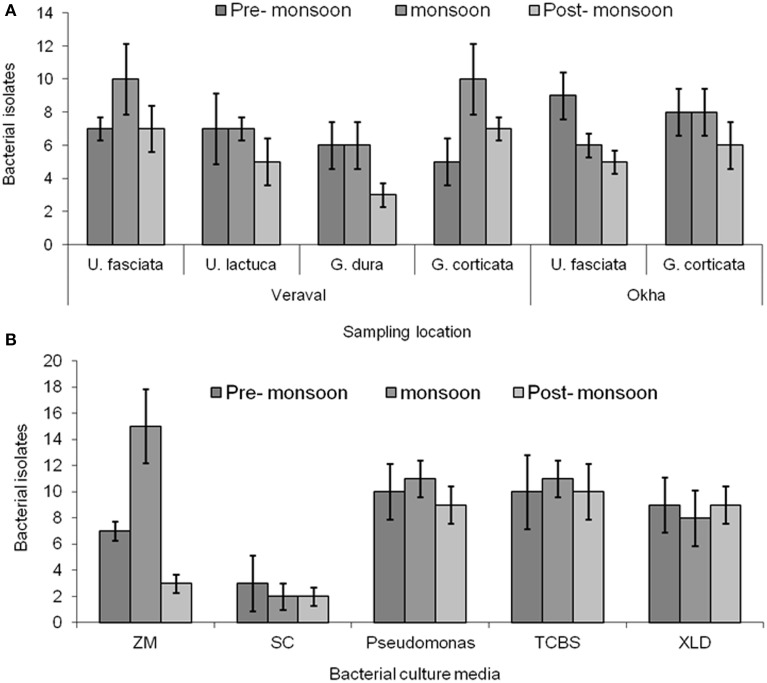
Bacterial isolation. (A) Enumeration of bacteria from different macroalgal samples such as Ulva fasciata, U. lactuca, Gracilaria dura and G. corticata. (B) Small plantlets of macroalgae were placed on the different culture media for isolating bacteria from them. Bars indicate, deviation of three independent replicates.